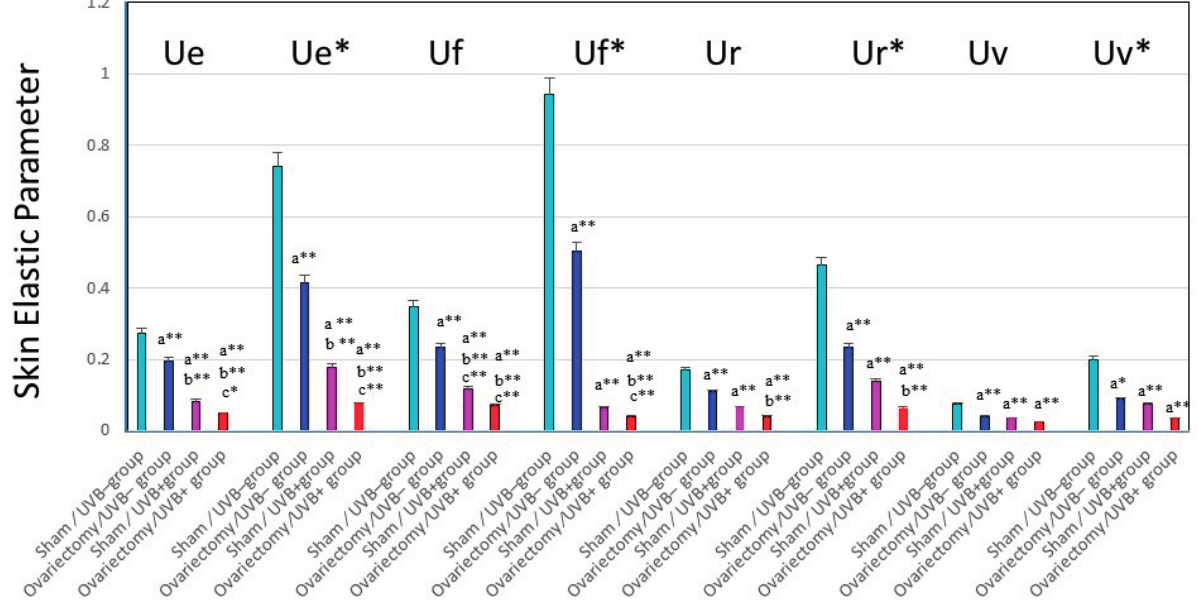
Figure 4. Changes in skin elastic parameters after ovariectomy, with or without UVB irradiation. Data represent means ± SD, n = 8. **, * p < 0.01, 0.05, a ( vs. sham/UVB − ); b ( vs. ovariectomy/UVB − ); c ( vs. sham/UVB+). At seven weeks old, 48 mice were